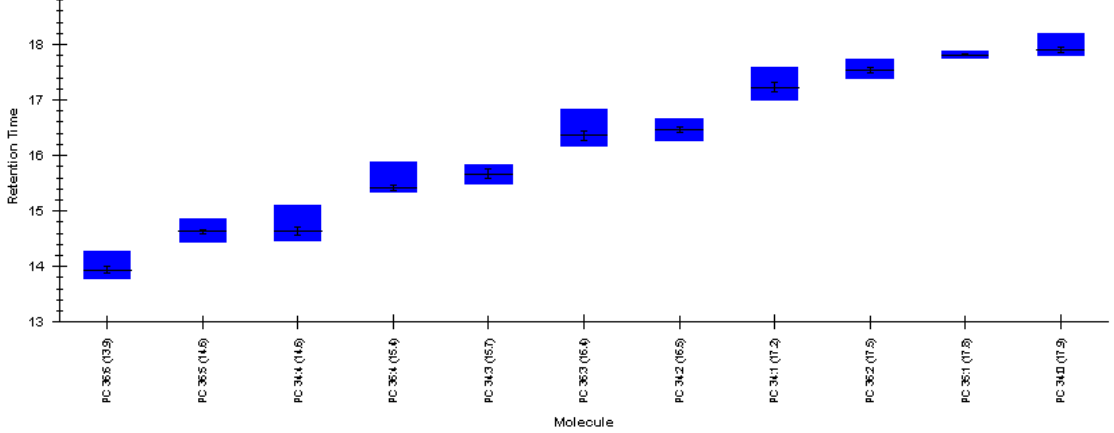
Figure A5. Retention time stability of the exemplary class of phosphatidylcholines (PCs) in the yeast control followed over the time course of 10 months.